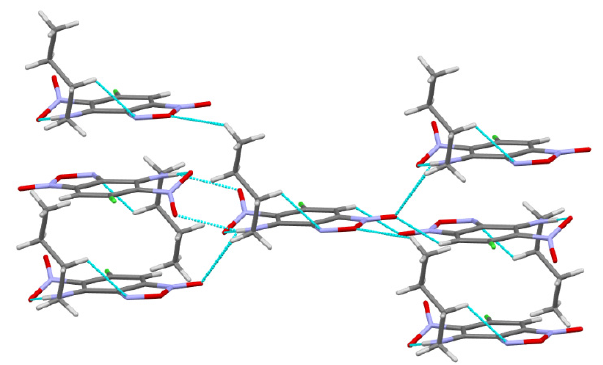
Figure 11. A packing of molecules in crystal of compound 4a.